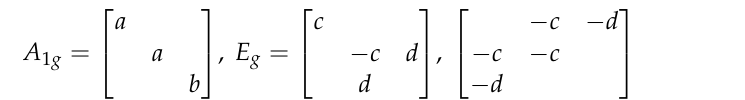
Figure 7. Raman spectra of SCAM by back-scattering from the c -plane with parallel (upper) and crossed (lower) polarizations plotted in logarithmic scale. 3.4. Optical Transmissions Transmission spectroscopy measurements were performed from ultraviolet to near- infrared by SHIMADZU UV-VIS-NIR Spectrophotometer UV-3600 at room temperature (RT). Figure 8 shows the transmission spectra of SCAM substrates with the thickness of (a) 259 µm, (b) 539 µm, and (c) 836 µm. These substrates were prepared by cleaving the same SCAM boule at a (0001) face by a razor blade. In the transmission spectra, a small valley around 290 nm was observed. The transmission reduction around this wavelength was also reported in the literature for SCAM crystals grown by CZ method [12] and by floating zone method [25]. At the wavelength longer than around 370 nm, the transmit- tance of SCAM substrates was almost the same value above 80%. The spectral fringes ob- served at the wavelength longer than 1 µm is caused by the thin sample thickness.